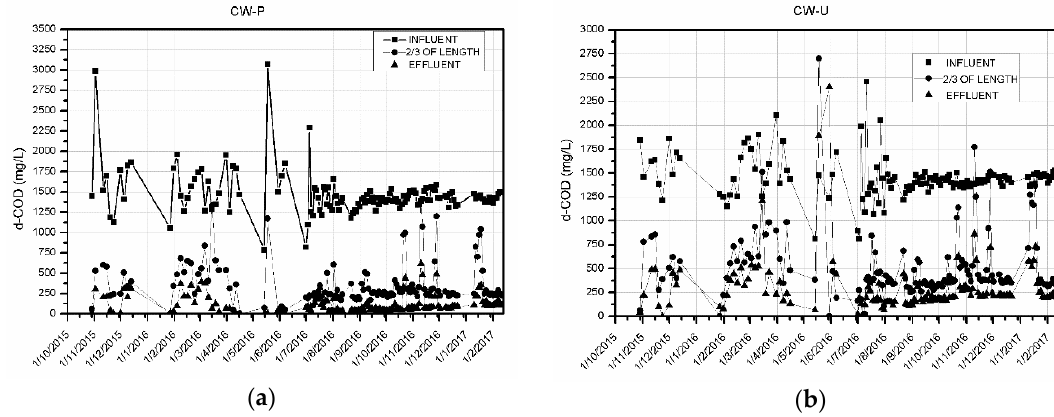
Figure 5. Time series charts for d-COD concentrations in the: ( a ) CW-P, and ( b ) CW-U unit.